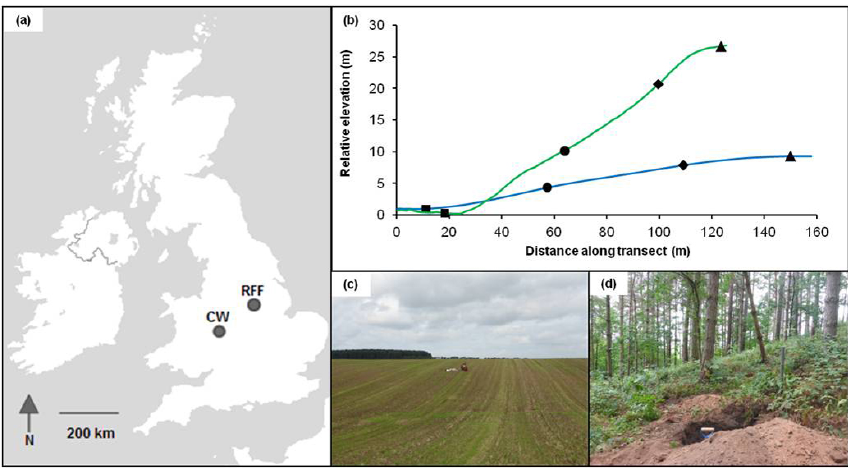
Figure 1. Locations of the study sites in this paper (a) with elevation profiles (b) for both Comer Wood (CW; green) and Rufford Forest Farm (RFF; blue). The position of summit (triangles), shoulder (diamonds), backslope (circles) and toeslope (squares) sampling positions are indicated on each profile. Photographs of RFF (c) and CW (d) were taken by the author at the time of sampling.